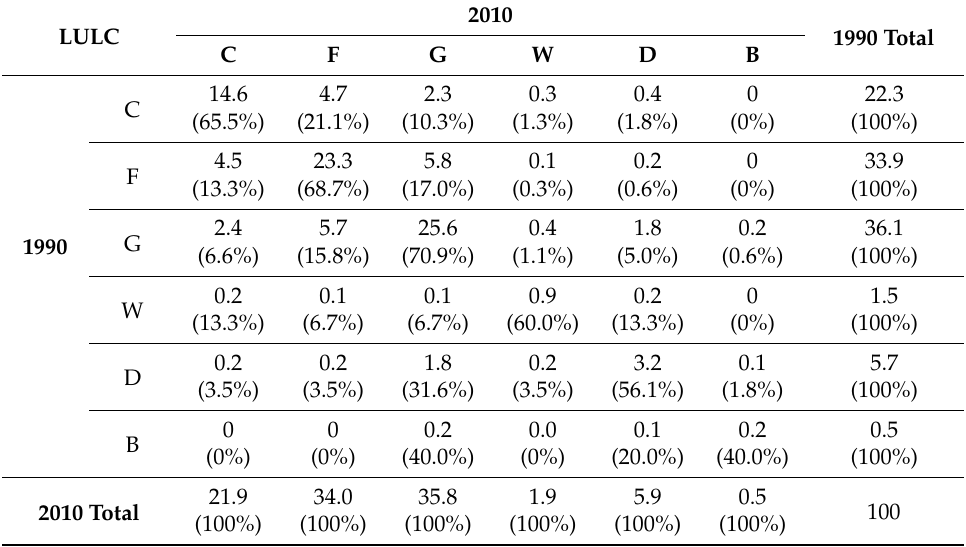
Table 5. Transform of each LULC type based on historical LULC maps (unit: × 10 4 km 2 ).